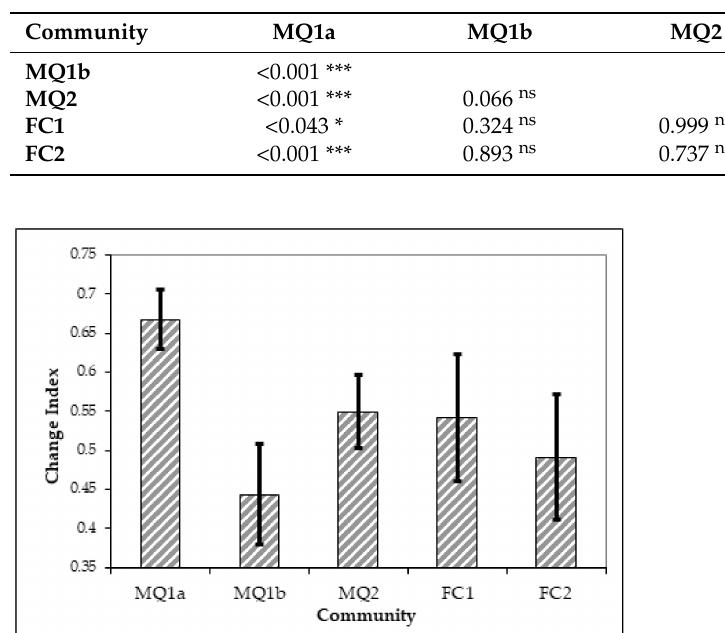
Table 6. Post Hoc pair-wise comparisons on the Change Index values between the communities 1989–2001. ns = Not significant, * = Significant, *** = Extremely significant.